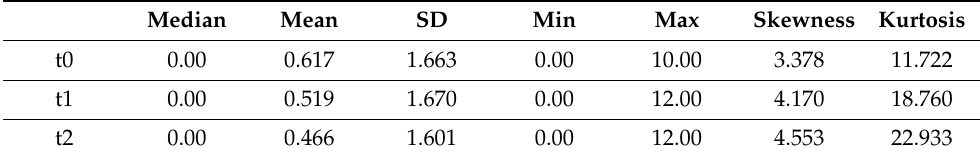
Table 2. Descriptive analysis of total IPV scores 1 in given time periods 2